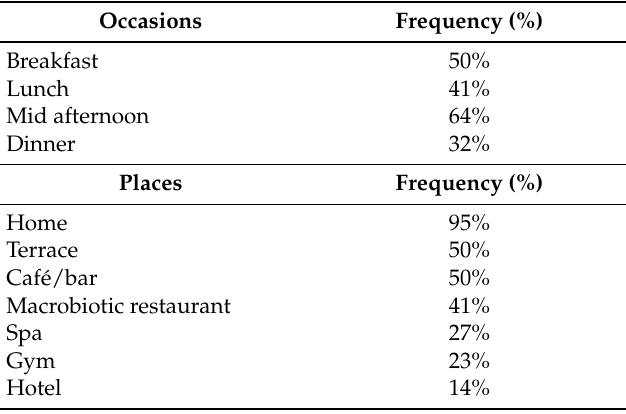
Table 5. Identified occasions and places for Bissap beverage consumption (frequency